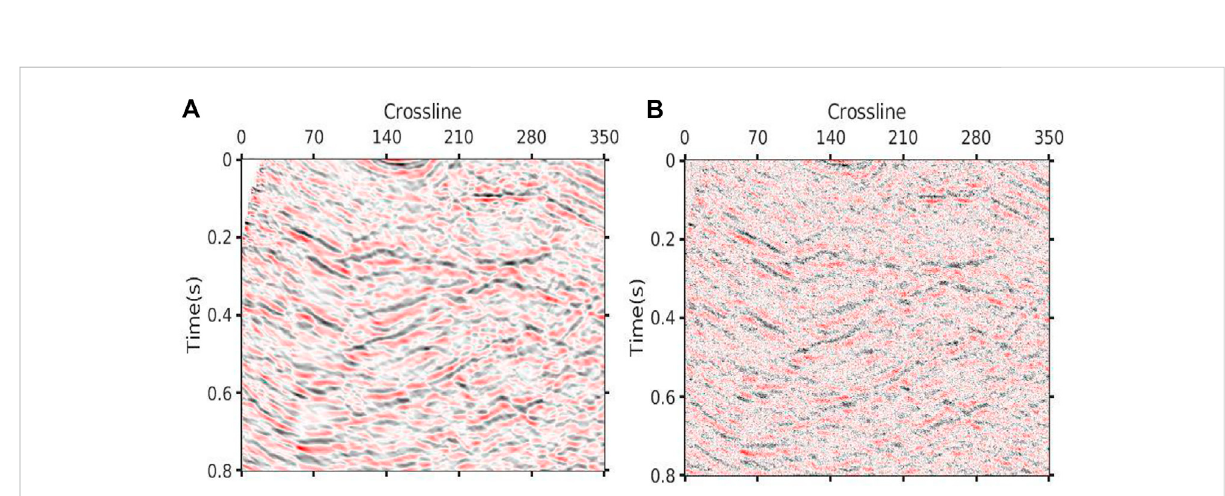
FIGURE 15 Original image and noisy image. (A) Original image. (B) Noisy image (SNR= − 2.55 dB PSNR=13.79